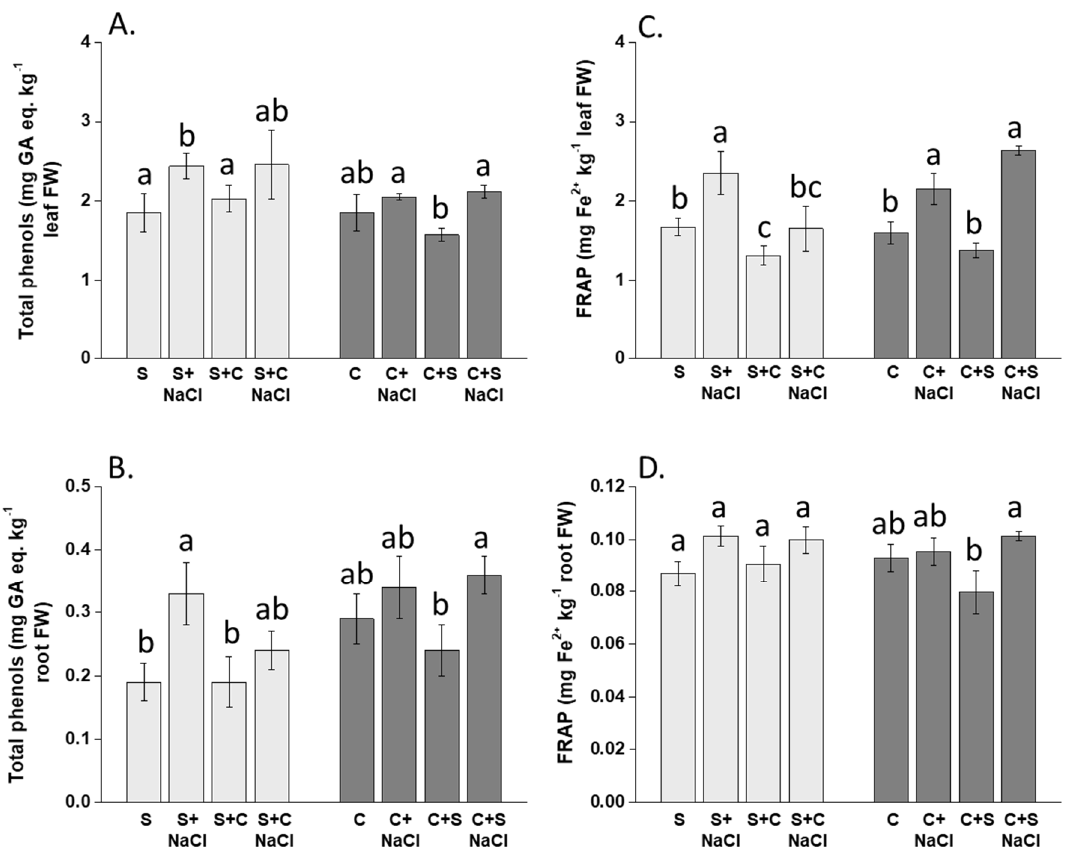
Figure 7. Total phenols in leaves ( A ) and roots ( B ) of soybean and C. album , treated and nontreated with NaCl. Ferric- reducing antioxidant power (FRAP), expressed as milligrams per kilogram of ferrous ion equivalent, in leaves ( C ) and roots ( D ) of soybean and C. album , treated and nontreated with NaCl. Different letters within each group of bars indicate significant differences at p < 0.05, n = 3. S = soybean; C = C. album . The experiment was replicated twice, and only data from one representative experiment are shown.